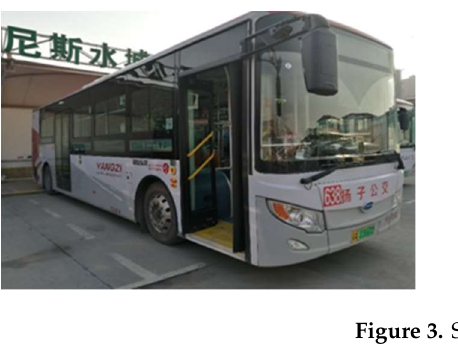
Figure 2. Yinlong brand.